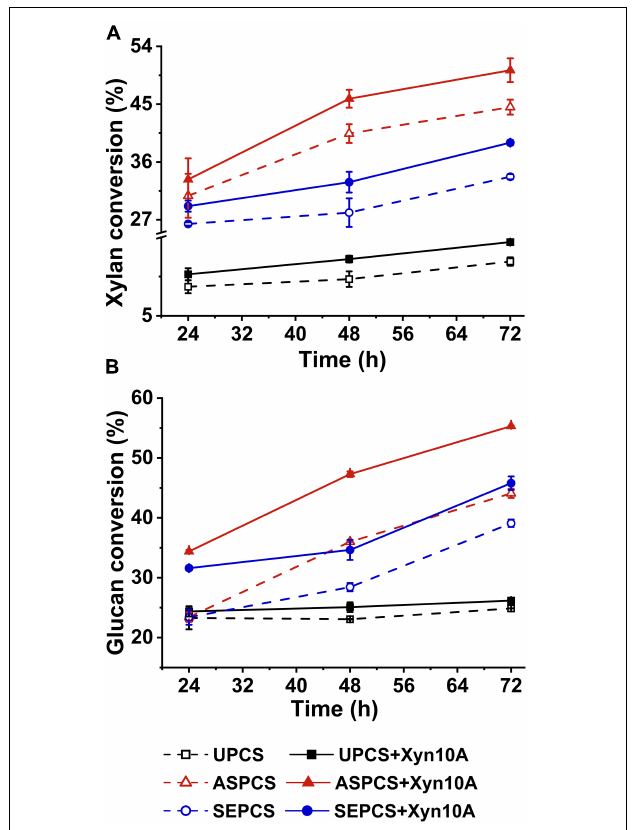
FIGURE 1 | Effect of Xyn10A addition on xylan conversion (A) and glucan conversion (B) during enzymatic hydrolysis of different-methods-pretreated corn stover. Note: UPCS, unpretreated corn stover; ASPCS, ammonium sulfite pretreated corn stover; SEPCS, steam explosion pretreated corn stover.